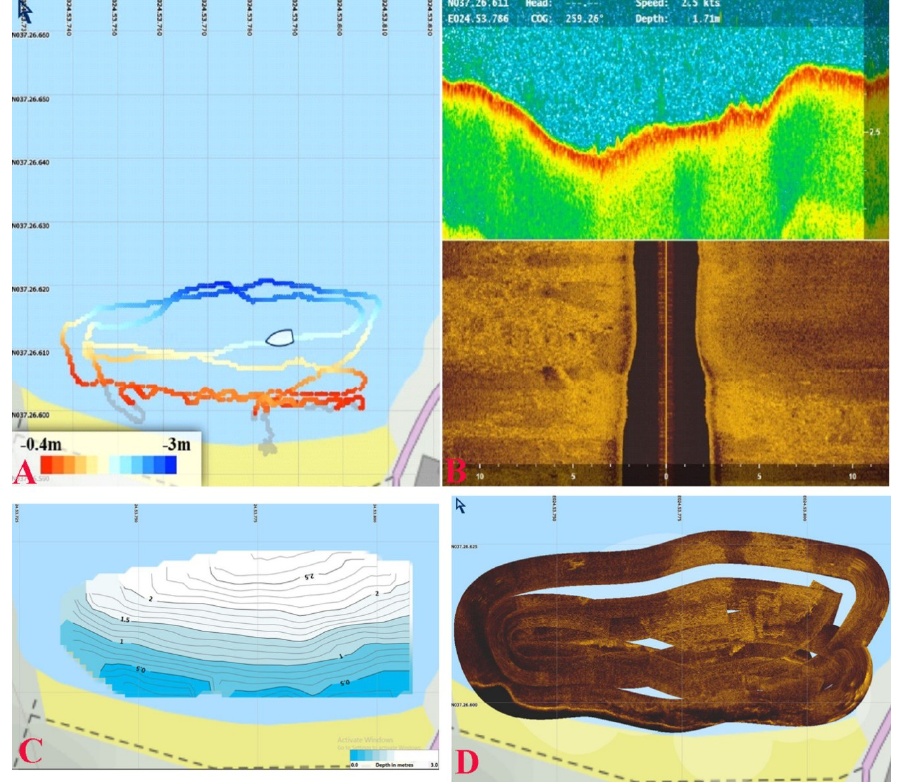
Figure 6. Example data from the Lowrance Elite-7 Ti and indicative processing steps in ReefMaster software. ( A ): part of the USV survey lines with colormap indicating bathymetry, ( B ): unprocessed bathymetric profile (upper half) and raw side scan sonar (SSS) sonograph (bottom half) as acquired through Lowrance Elite-7 Ti, ( C ): rough bathymetric map of the area of beachrocks and ( D ): an example of mosaicked SSS data (incomplete data).